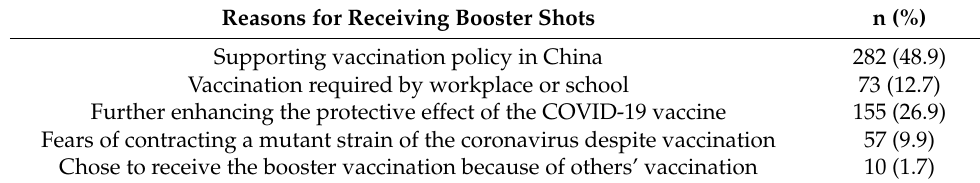
Table 3. Reasons for receiving booster shots (n =